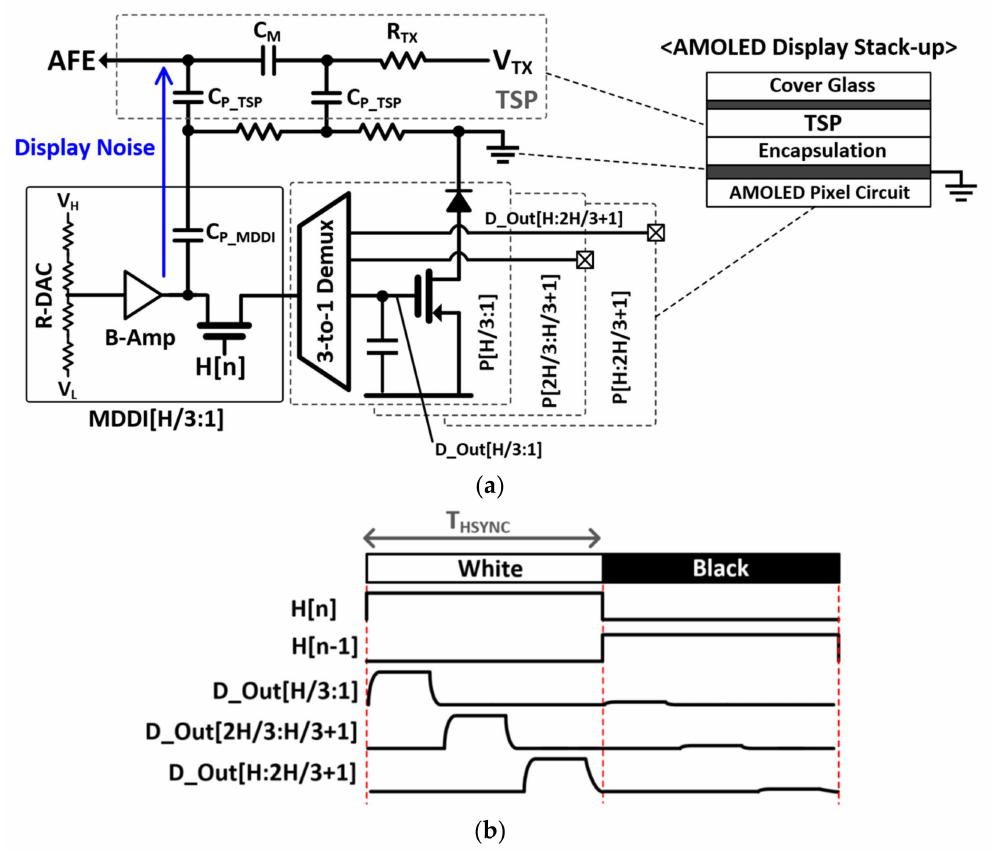
Figure 1. ( a ) An equivalent circuit consisting of an AMOLED, a TSP and an MDDI, and ( b ) a timing diagram of the MDDI operation using a 3-to-1